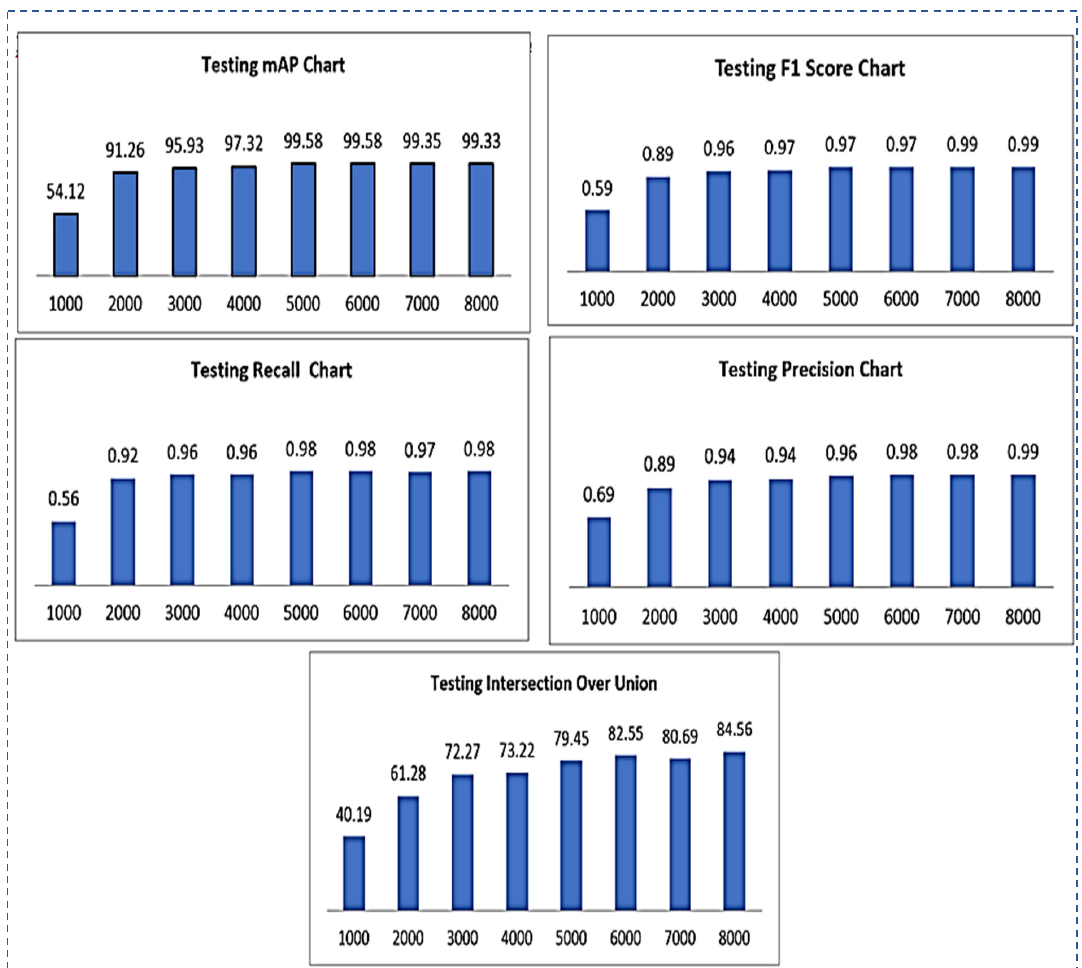
Figure 7. Testing results chart representation for mAP, F1 ‐ Score, recall, precision, IOU. Output Images using the best weight obtained for all teeth diseases are shown in Figure 8.